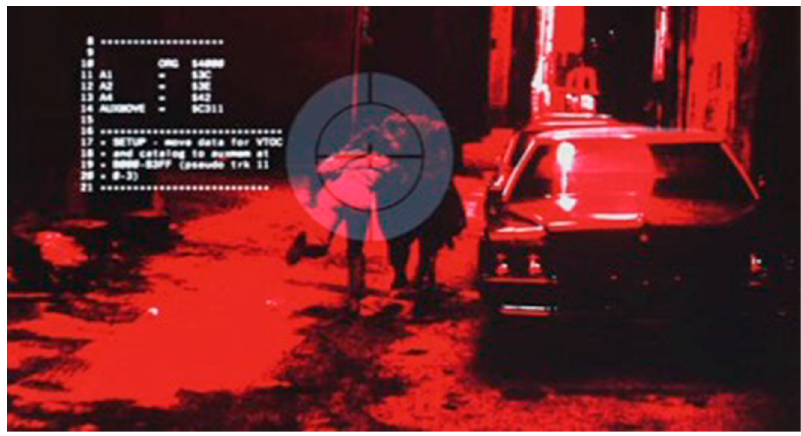
Figure 1. Image from The Terminator (1984) [20].